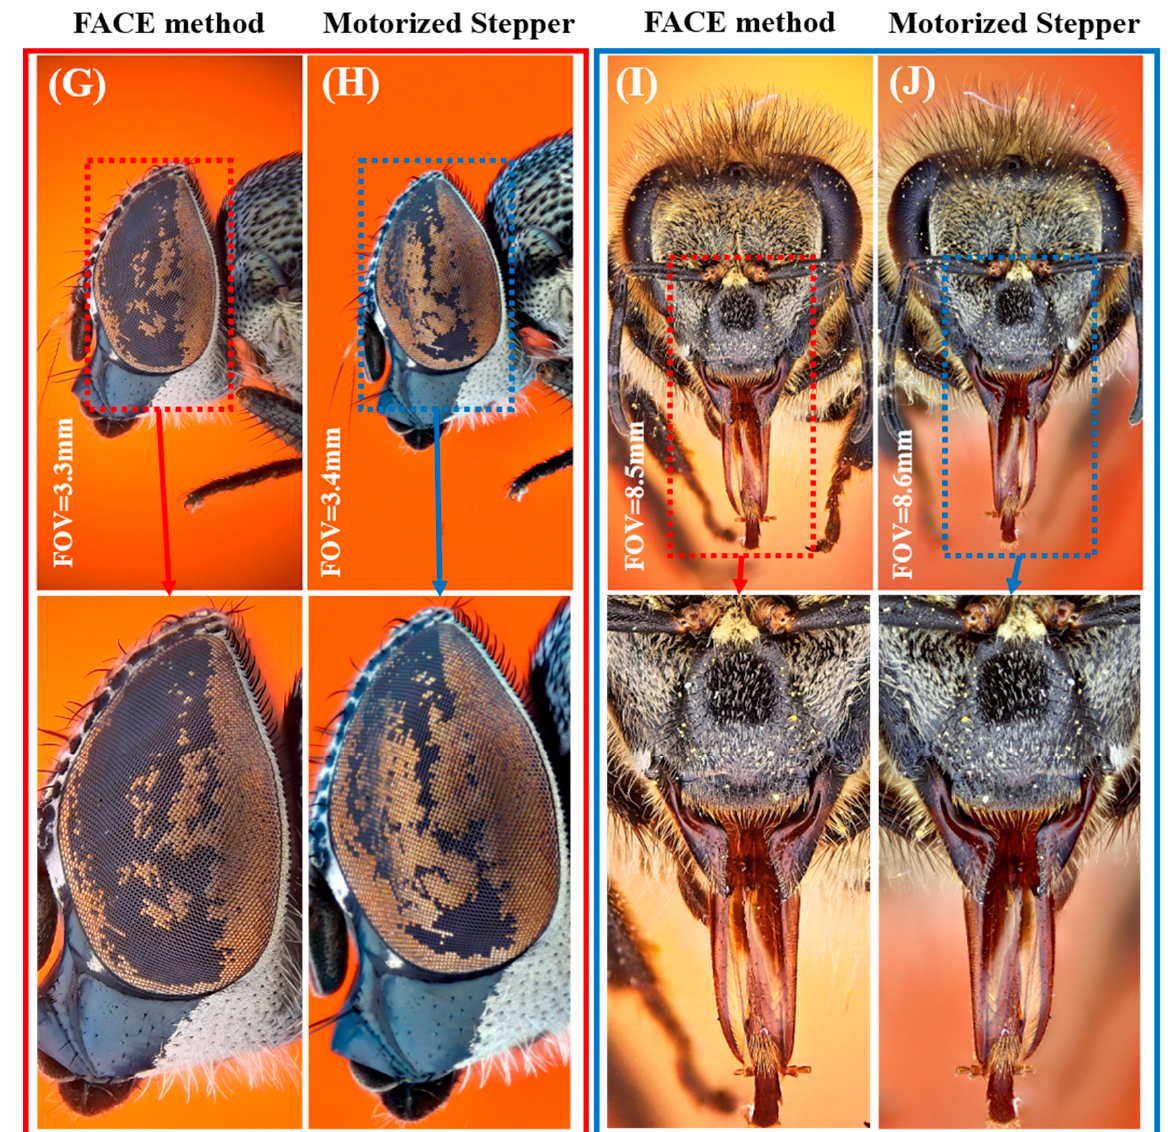
Figure 4. The comparisons of several stacked images of various insects shot at different orientations by FACE (red color) and motorized stepper (blue color) methods. ( A , B ) Ventral view images of fly stacked from 163 and 166 images captured by the FACE system and motorized stepper, respectively, with 2.5× magnification. ( C , D ) Ventral view images of the fly head stacked from 180 photos captured by the FACE system with a 4× objective lens at a 2.5× magnification and 81 photos captured by the motorized stepper system at a 5× magnification with 65 mm extension tubes, respectively. ( E , F ) Dorsal view images of an ant stacked from 91 images captured by the FACE system with a 4× objective lens at a 2.5× magnification and 51 images captured by the motorized stepper system at a 5× magnification with 65 mm extension tubes, respectively. ( G , H ) Lateral view images of the hoverfly stacked from 155 photos captured by the FACE system with a 4× objective lens at a 2× magnification and 81 photos captured by the motorized stepper system at a 4× magnification with 65 mm extension tubes, respectively. ( I , J ) Frontal view images of a honeybee stacked from 249 images captured by the FACE system at a 2.5× magnification and 166 images captured by the motorized stepper at a 2.5× magnification, respectively. Zoom-in inset images of the same image regions in every comparison are provided below each image.